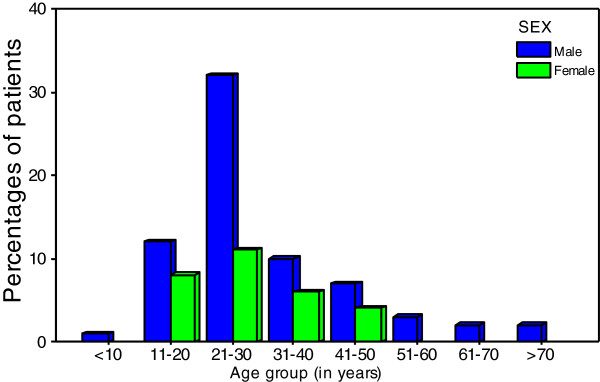
Distribution of age group according to sex.